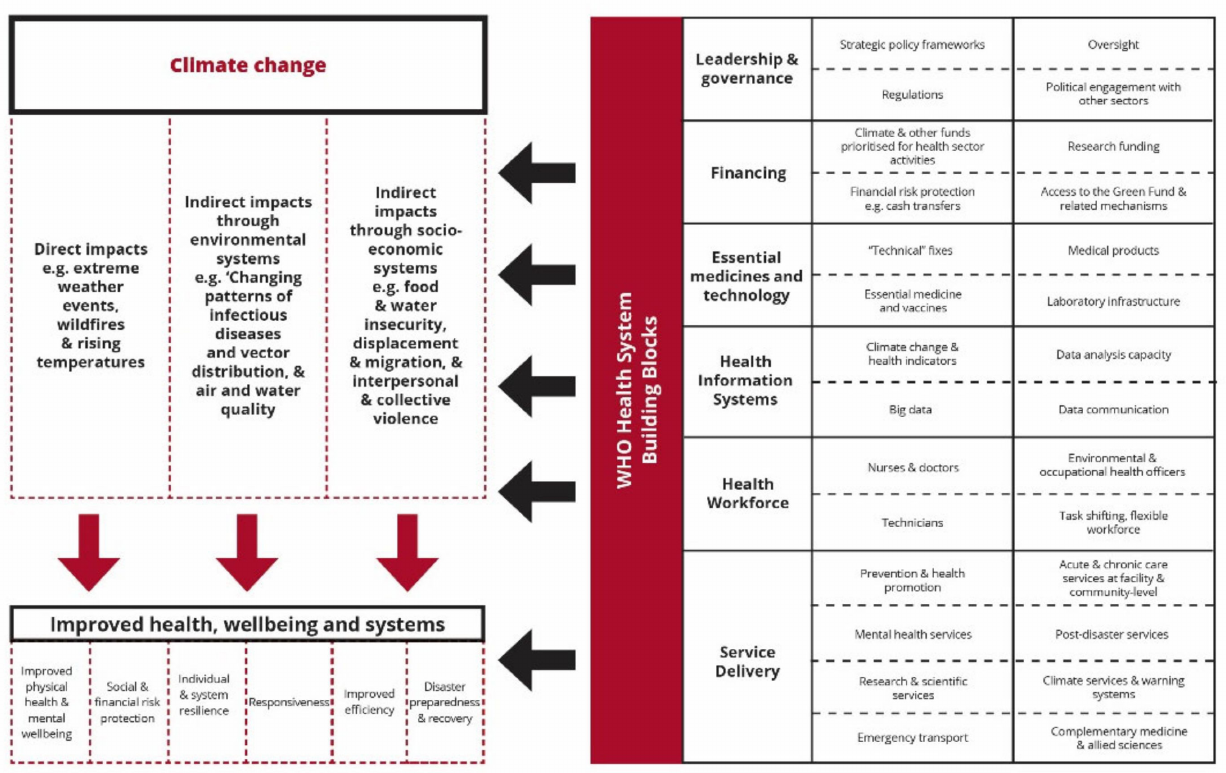
Figure 1. Unpacking a climate change adaptation framework based on the WHO Health Systems Building